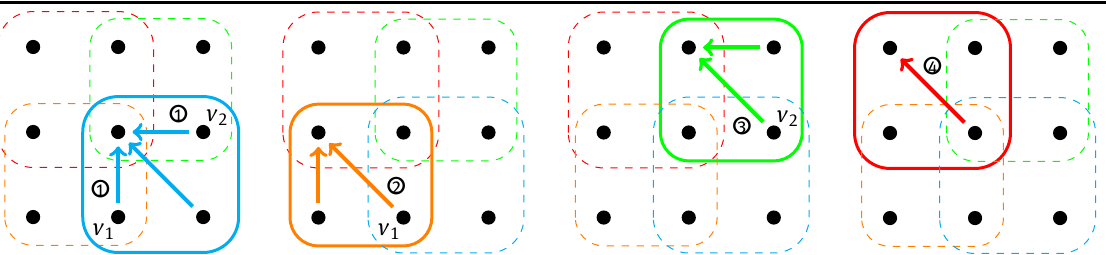
Figure 6: Another transport from Figure 4. The weights transported at the arrows 1 ○ , 2 ○ , 3 ○ , 4 ○ are 1 ○ = β /24, 2 ○ = 3 ○ = β /12, 4 ○ = α − β /3 .